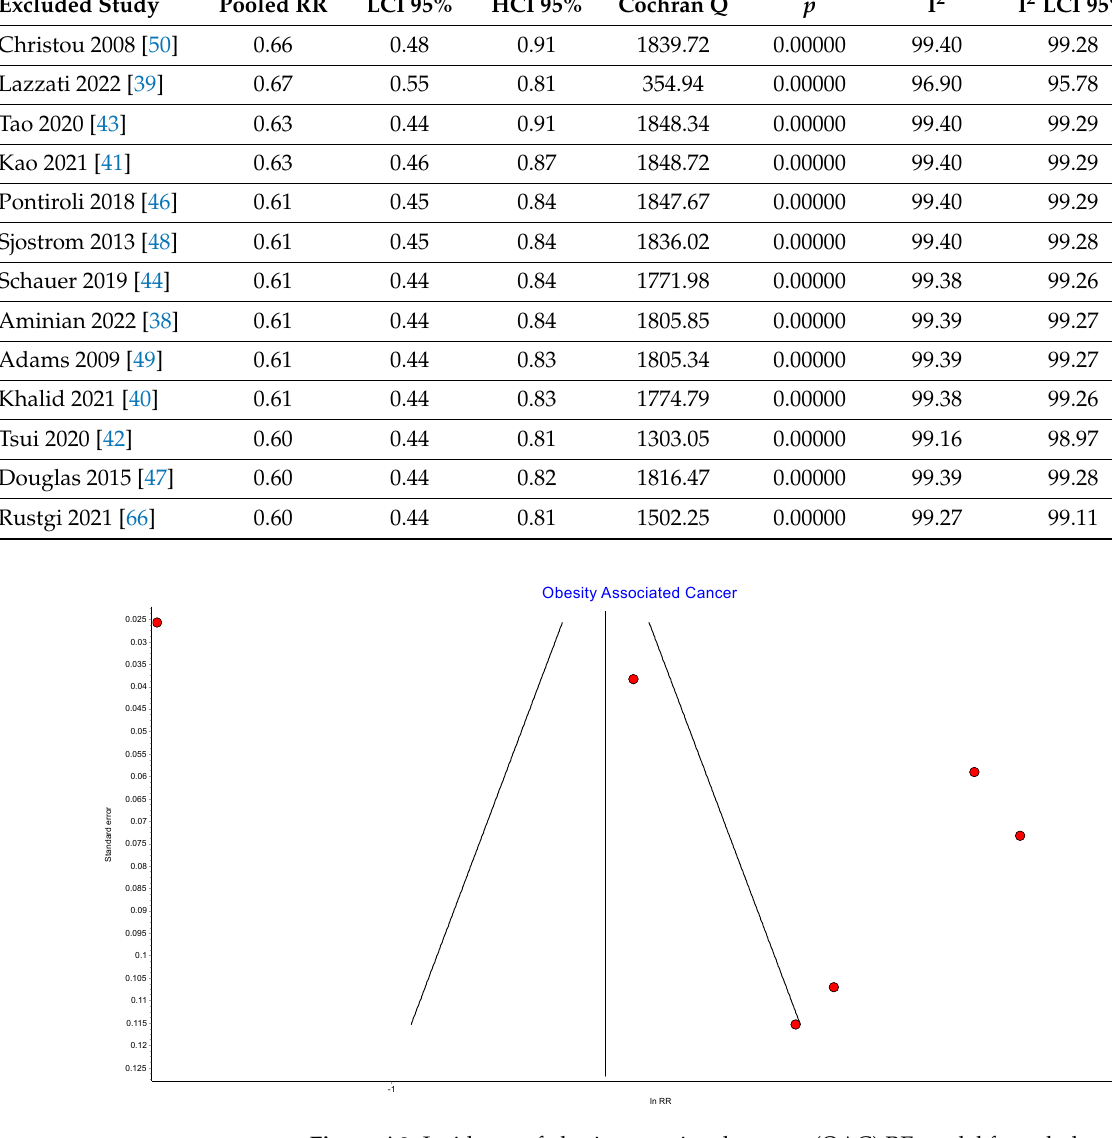
Table A1. Overall cancer incidence RE model sensitivity analysis.